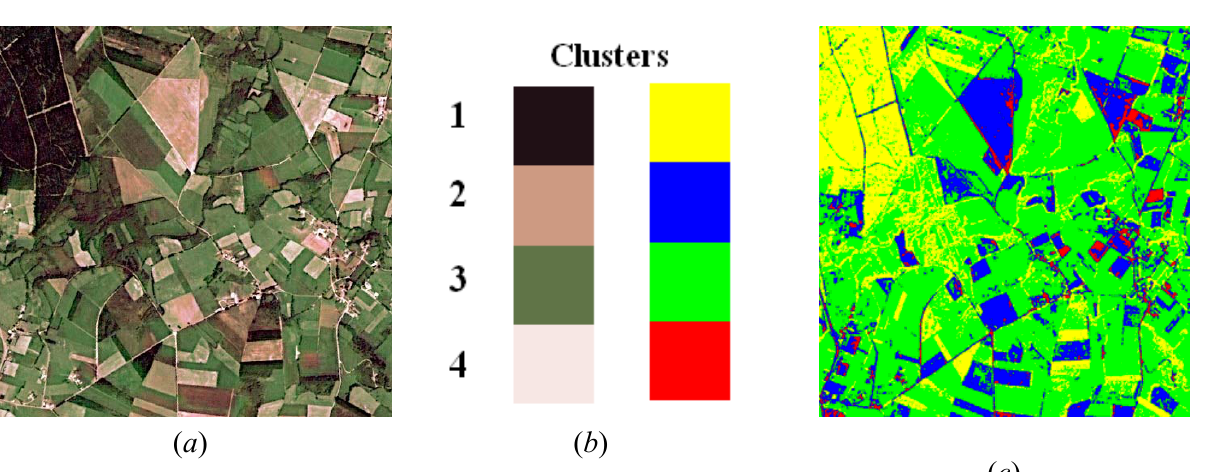
Figure 1. ( a ) original image belonging to the set S0; ( b ) correspondence between classes and labels; ( c ) labelled image with the four classes according to the labels in ( b